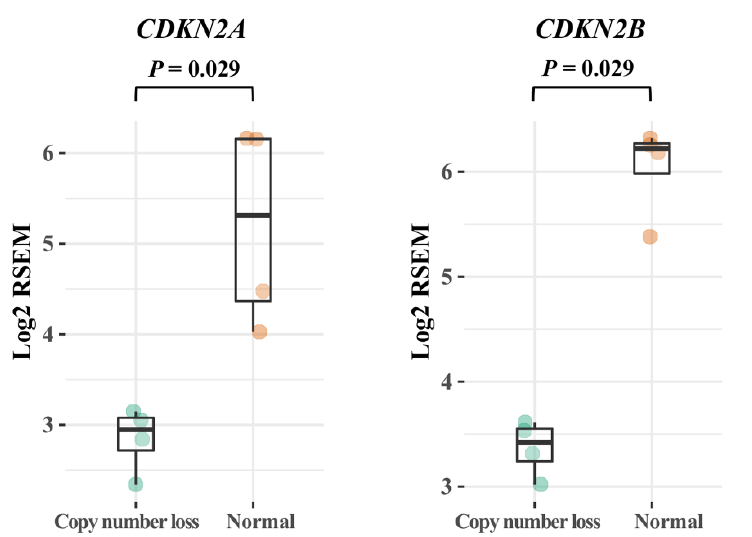
Figure 2. Expression of CDKN2A and CDKN2B mRNA in correlation to the corresponding gene copy number. The anaplastic thyroid carcinoma cases exhibiting synchronous copy number loss of both CDKN2A and CDKN2B ( n = 4; 50%) display significantly lower mRNA expression of both genes compared to diploid cases ( n = 4; 50%). p values < 0.05 were considered statistically significant (Mann–Whitney U).